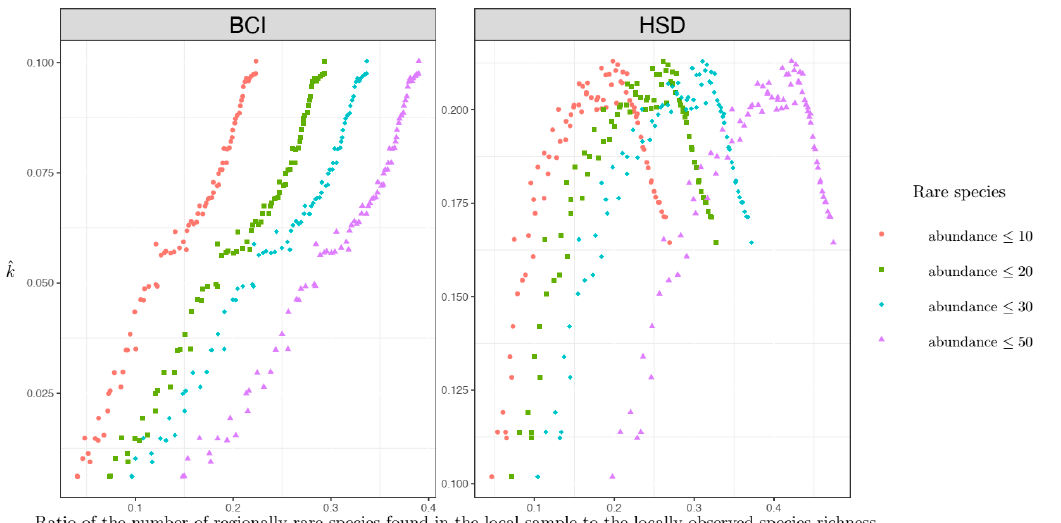
Figure 3. Multiscale relationships between the shape parameter k estimated from the randomly sampled local communities and the percent of regionally rare species (defined as a regional population size or abundance ≤ 10, 20, 30, and 50 at the whole plot level) in these sampled communities for the two permanent forest plots.